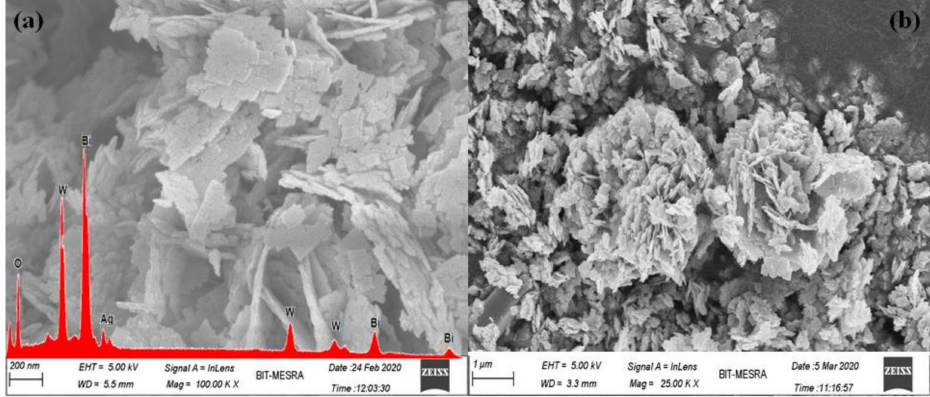
Figure 5. FESEM images of Ag/Bi 2 WO 6 (1:2). ( a ) nanosheets are visible at 100.00 k × magnification; ( b ) circular colonies are visible at 25.00 K ×